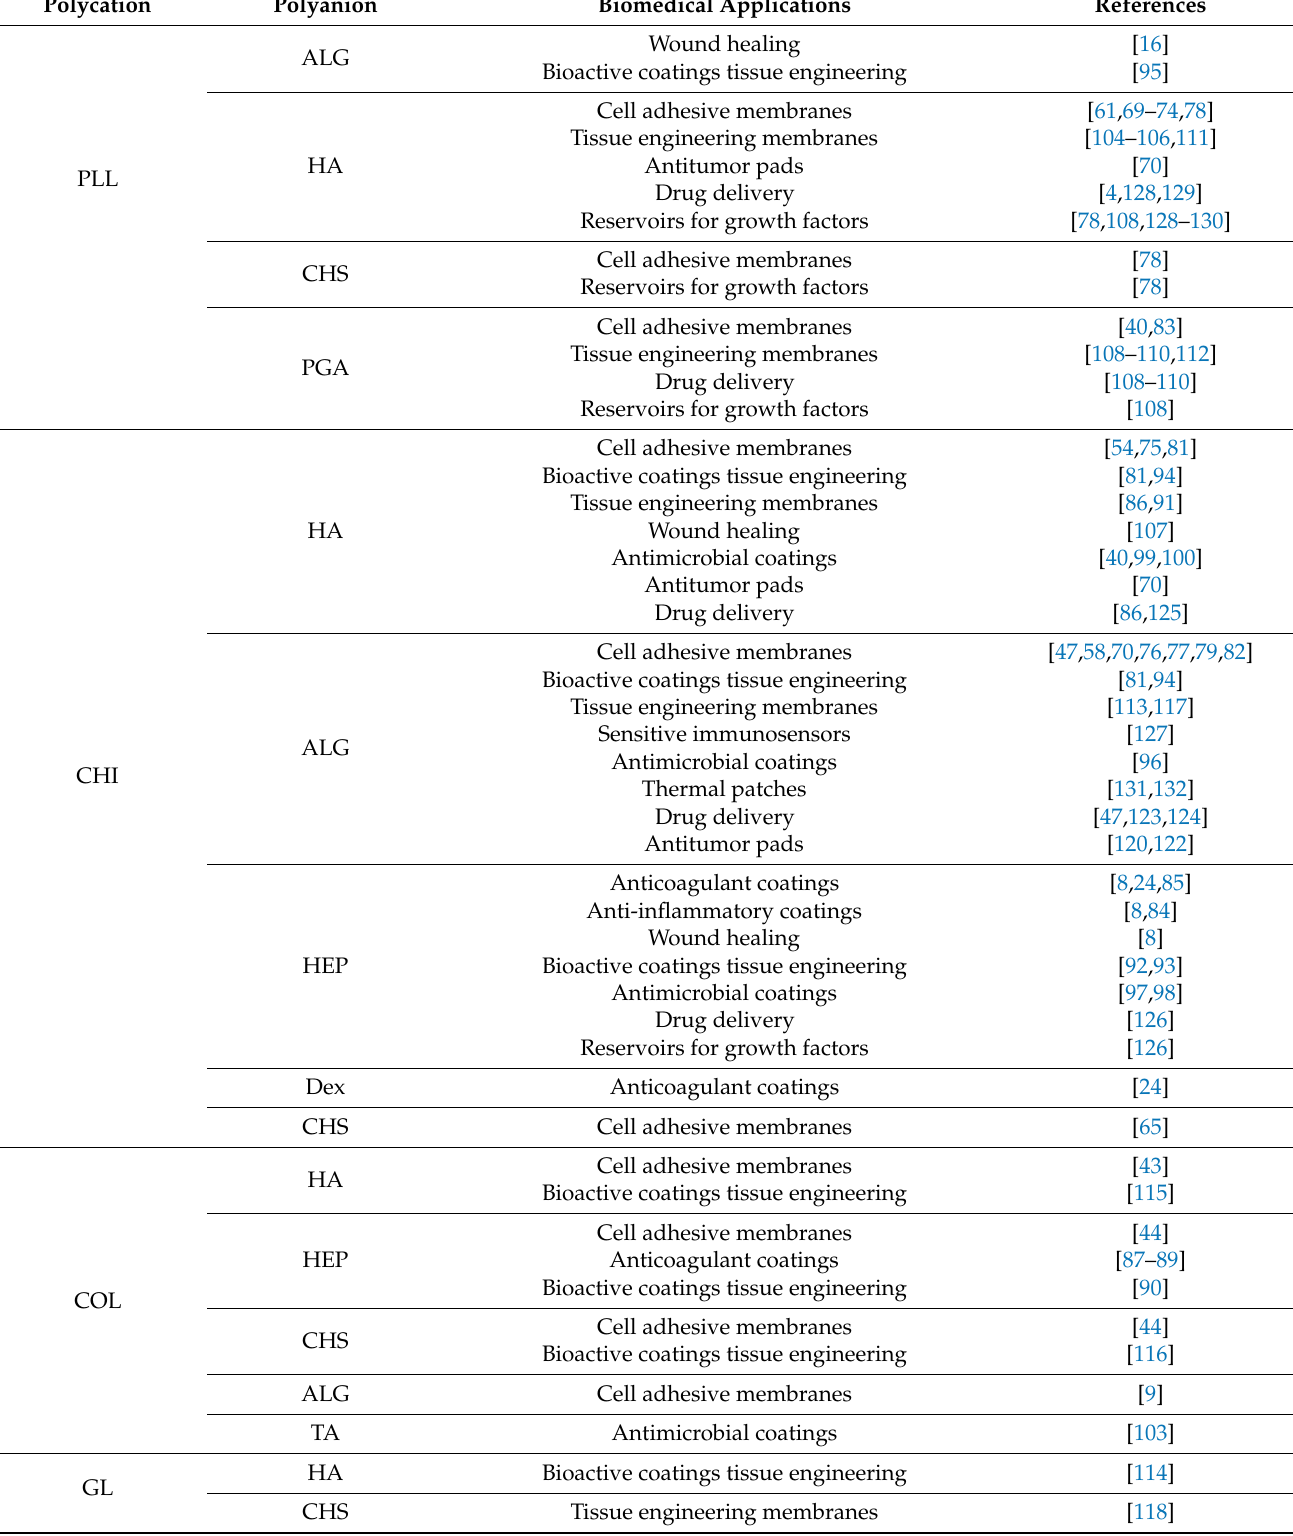
Table 1. Summary of the multilayer films based on natural polymers with PLL, CHI, COL, and GL as polycations and several polyanions, type of LbL assembly technique employed, and potential biomedical